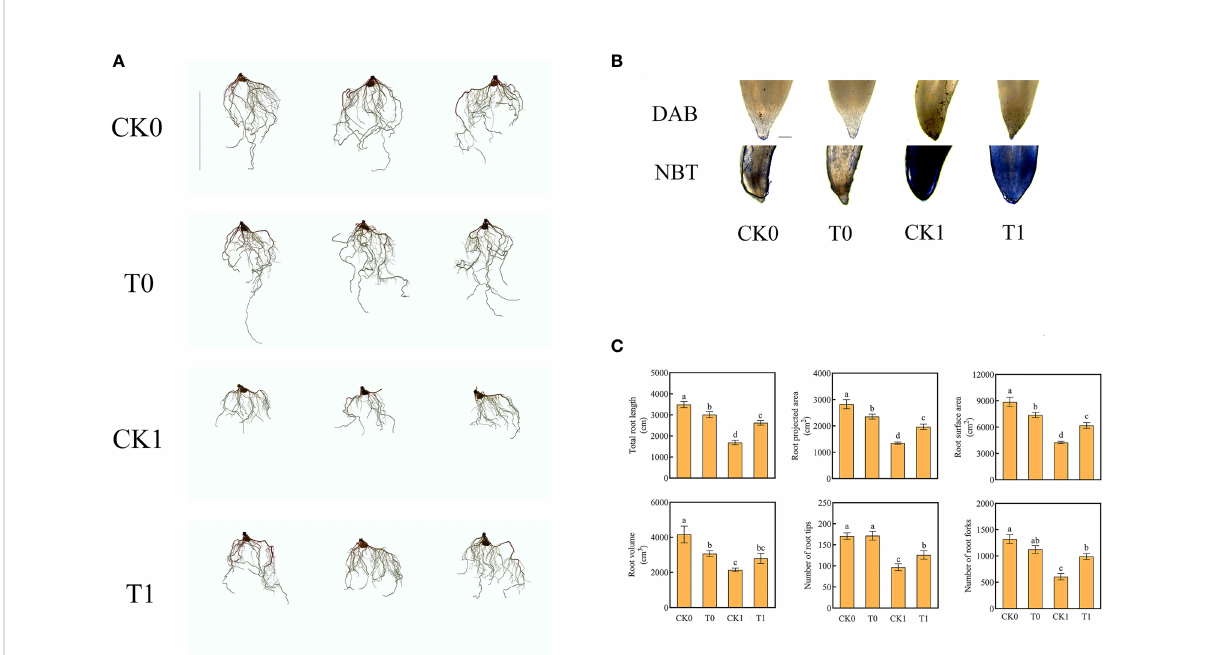
FIGURE 1 Rootmorphology (Ruler represents 20cm) (A) , roottips with DAB and NBT staining(Ruler represents 200 m m) (B) , total rootlength, root projected area, rootsurfacearea, rootvolume, number ofroot tips, numberof rootforks (C) in the fourdifferent treatments. Data werepresented as the mean ± SEM for six biological replicate samples. Barslabeled with different letters indicated signi fi cant differencebetween